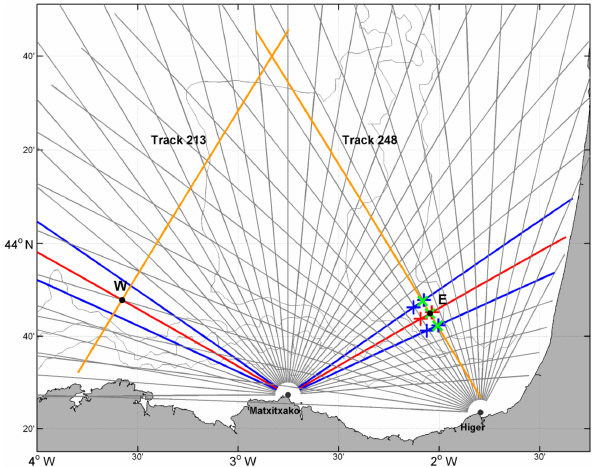
Figure 2. Schematic view of the pointwise comparison and of the data used for this approximation. Jason-2’s 213 and 248 tracks are depicted by orange lines. The HFR radial directions from both sites are represented by grey lines and the selected radial directions (from the Matxitxako site) for the pointwise comparison are plotted in red (the central radial orthogonal to the track) and in blue (the adjacent radials). Points E and W are those along both tracks, where each of the HFR radial directions are orthogonal to the Jason-2’s track directions. At point E , the blue and red crosses show the selected points of HFR radial directions where radial currents are averaged in a first step to obtain the corresponding values on the track (green crosses). Then, the along-track green crosses are averaged to obtain the corresponding HFR current values at the point at issue (the same process is carried out for point W , but it is not represented in the figure). Grey lines: 200, 1000, and 2000m